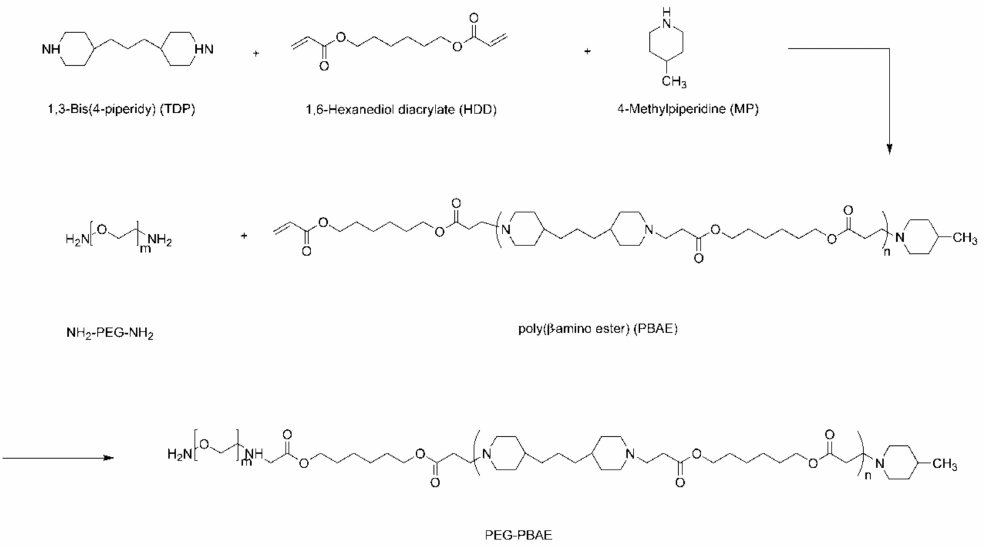
Scheme 2. Synthetic route of PEG-PBAE.